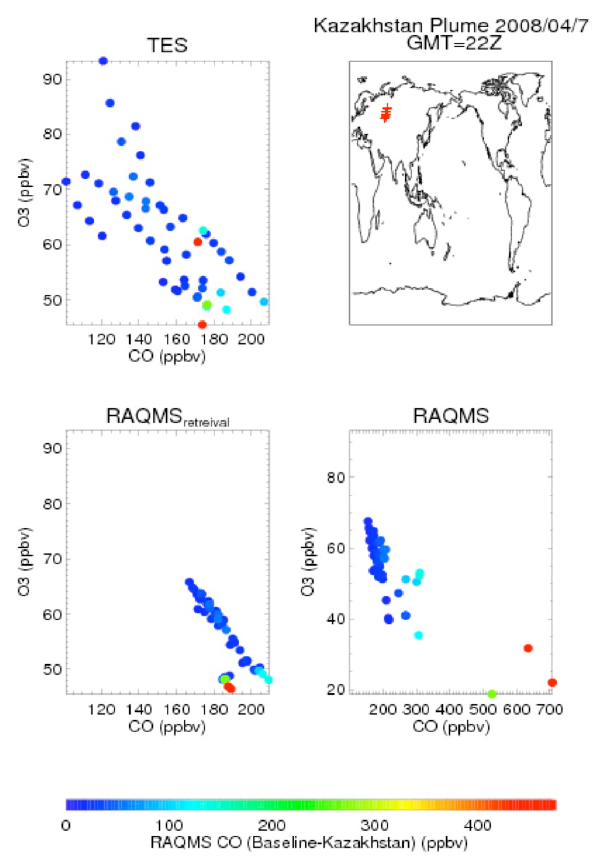
Figure 8a : (top left) TES ozone and CO over Kazakhstan fires. (top right) TES measurement locations. (bottom right) RAQMS estimates of CO and ozone. (bottom left) RAQMS estimates of CO and Ozone after applying TES a priori and averaging kernel to RAQMS estimates.